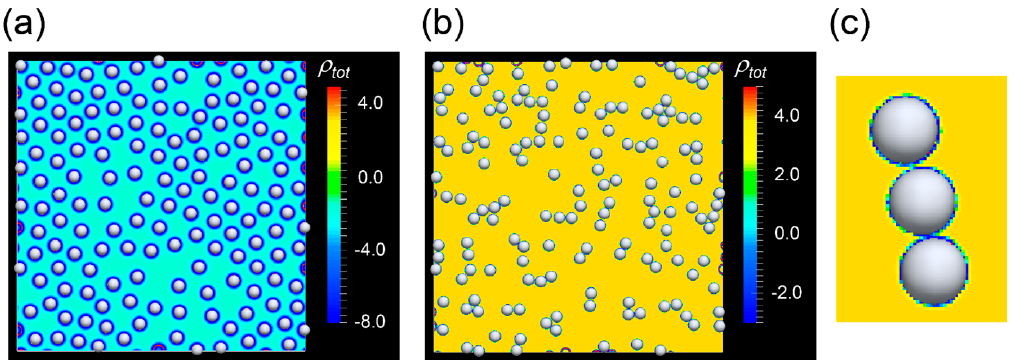
Figure 2. Morphogenesis of vascular endothelial cells. White spheres indicate cells, and the color shows the sum of concentration of ions ρ tot : ( a ) without salt (only the counter ions of cells are considered) and ( b ) with salt (C α = 20 µ M). This corresponds to the early stage of vascular network formation; ( c ) Expanded View of a chain composed by three cells. Cells are surrounded by ions denoted by the color field which is the same as ( b ).